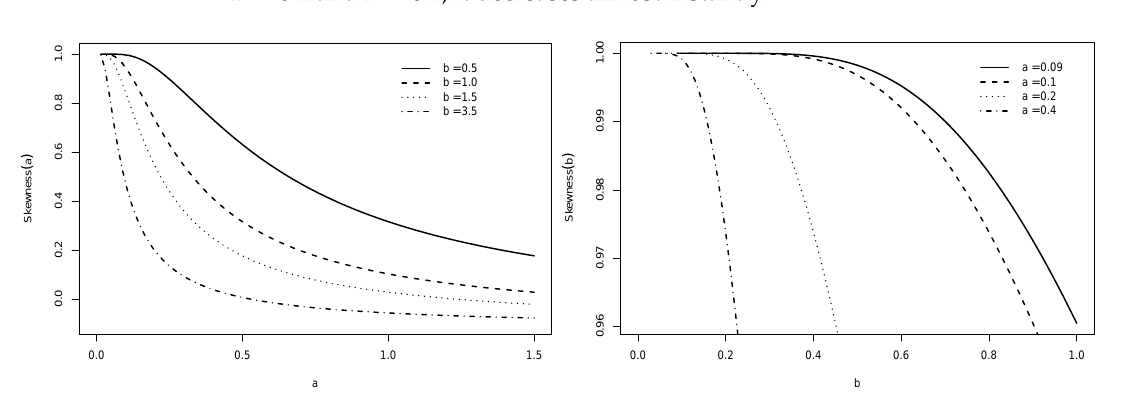
Figure 3b shows that the skewness starts constantly when b grows and then decays. For a = 0.2 and a = 0.4, it decreases almost instantly.